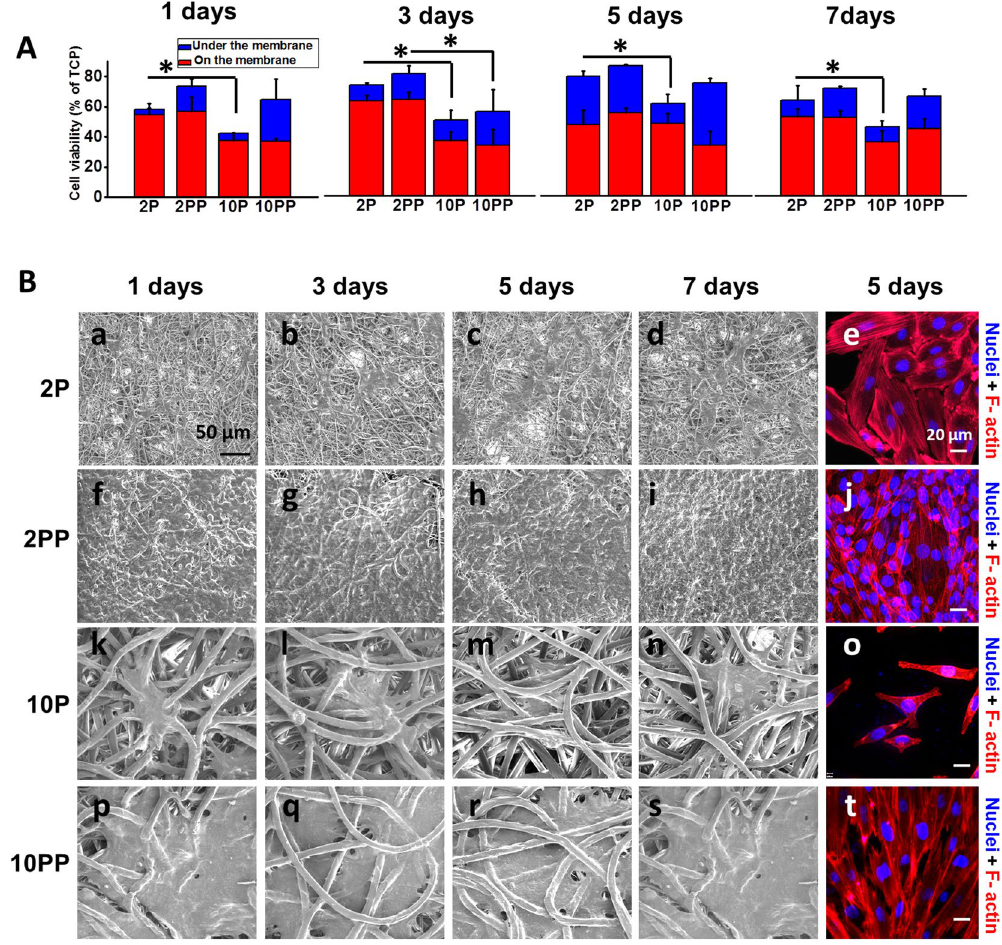
Figure 4. Thinner functionalized electrospun PCL microfibers (2 PP) were more effective for the muscle cell proliferation and adhesion. ( A ) After cultured on PCL fibrous membranes for 1, 3, 5 and 7 days, cell proliferation was detected using CCK-8. ( B ) ESEM and fluorescent images of cells on PCL fibrous